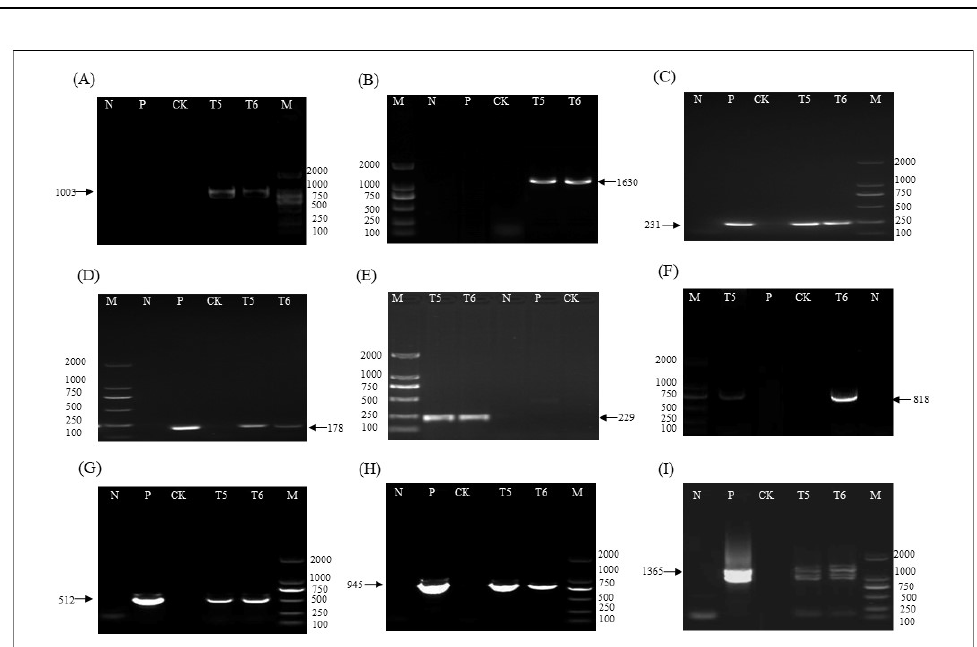
Figure 6. The PCR analysis of each genetic element in T5 and T6 ZHs1-2 transformation events. ( A ) Left border at Chr 02 with the predicted target band size 1003 bp; ( B ) right border at Chr 02 with the predicted target band size 1630 bp; ( C ) Bar gene with the predicted target band size 231 bp; ( D ) Hs1 pro −1 gene with the predicted target band size 178 bp; ( E ) left border at Chr 03 with the predicted target band size 229 bp; ( F ) right border at Chr 03 with the predicted target band size 818 bp; ( G ) terminator Tvsp and Bar gene with the predicted target band size 512 bp; ( H ) Hs1 pro −1 gene and ter- minator nos gene with the predicted target band size 945 bp; ( I ) Bar gene and 2 × 35S promoter with the predicted target band size 1365 bp. M, DNA Marker (from top to bottom: 2 kb, 1 kb, 750 bp, 500